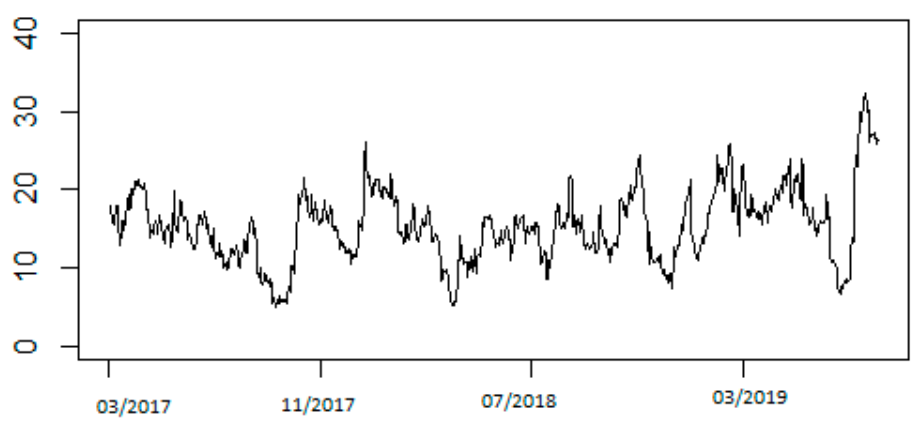
Figure 6. Total connectedness between bitcoin, gold, and crude oil returns. Note: The total connectedness by Diebold and Yilmaz (2012, 2014), computed on a moving window with a length of 50 days.